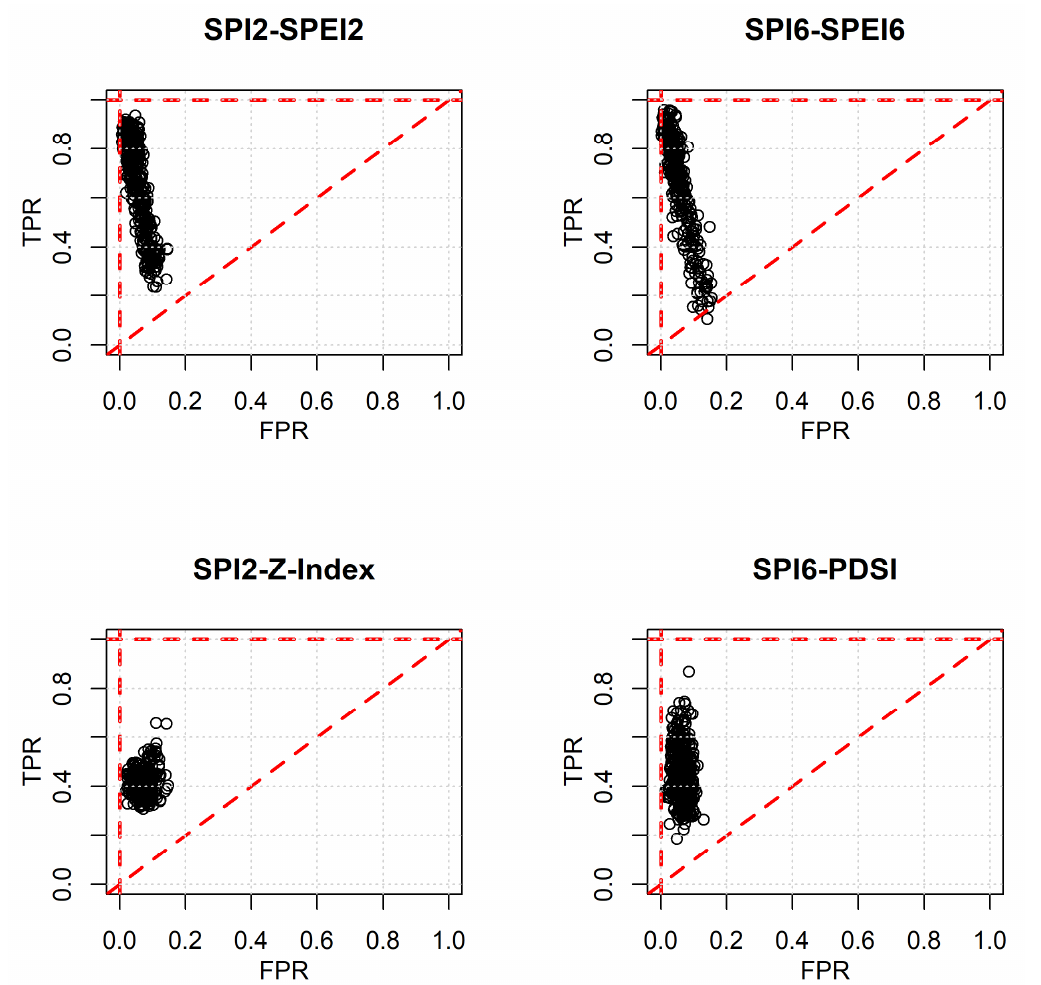
Figure 8. Receiver Operator Characteristics (ROC) curve for various meteorological-agricultural drought combinations.